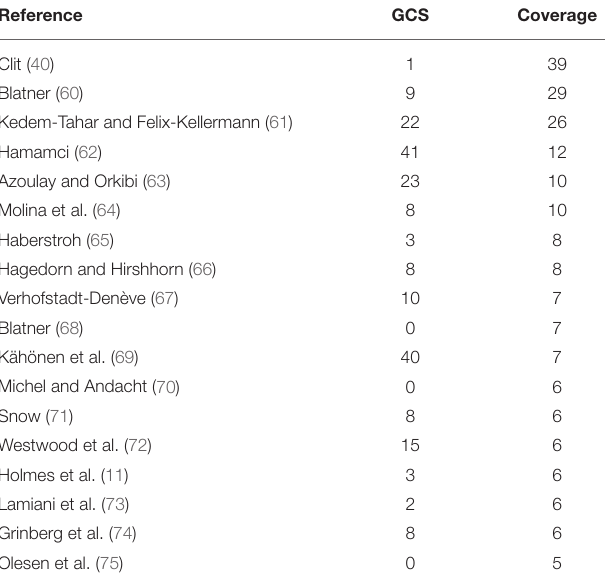
TABLE 3 | Keywords with significant citation burstness generated by keyword analysis.